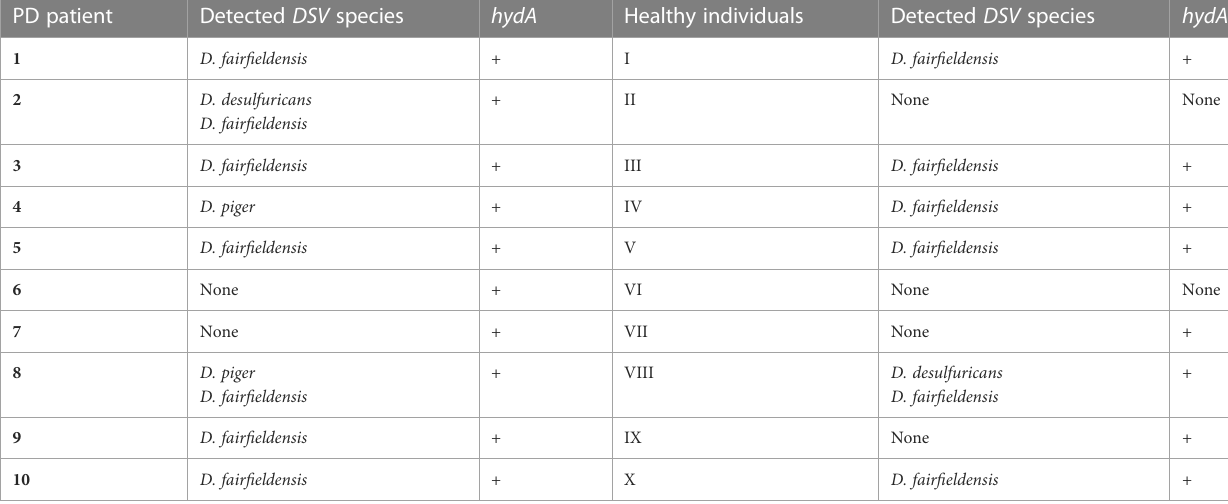
TABLE 2 PCR detection of Desulfovibrio bacteria in the feces of PD patients and healthy